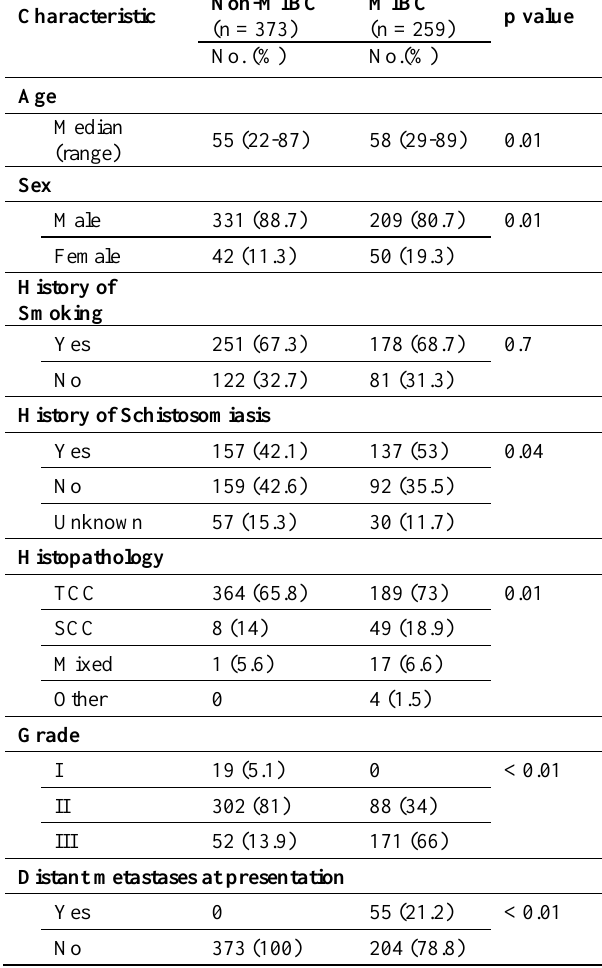
Table 2: Correlation between invasiveness of bladder cancer and different clinical and pathological characteristics